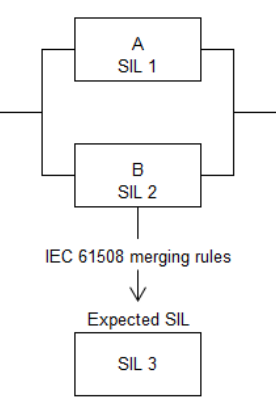
Fig. 6. SIL parallel merging rule in IEC